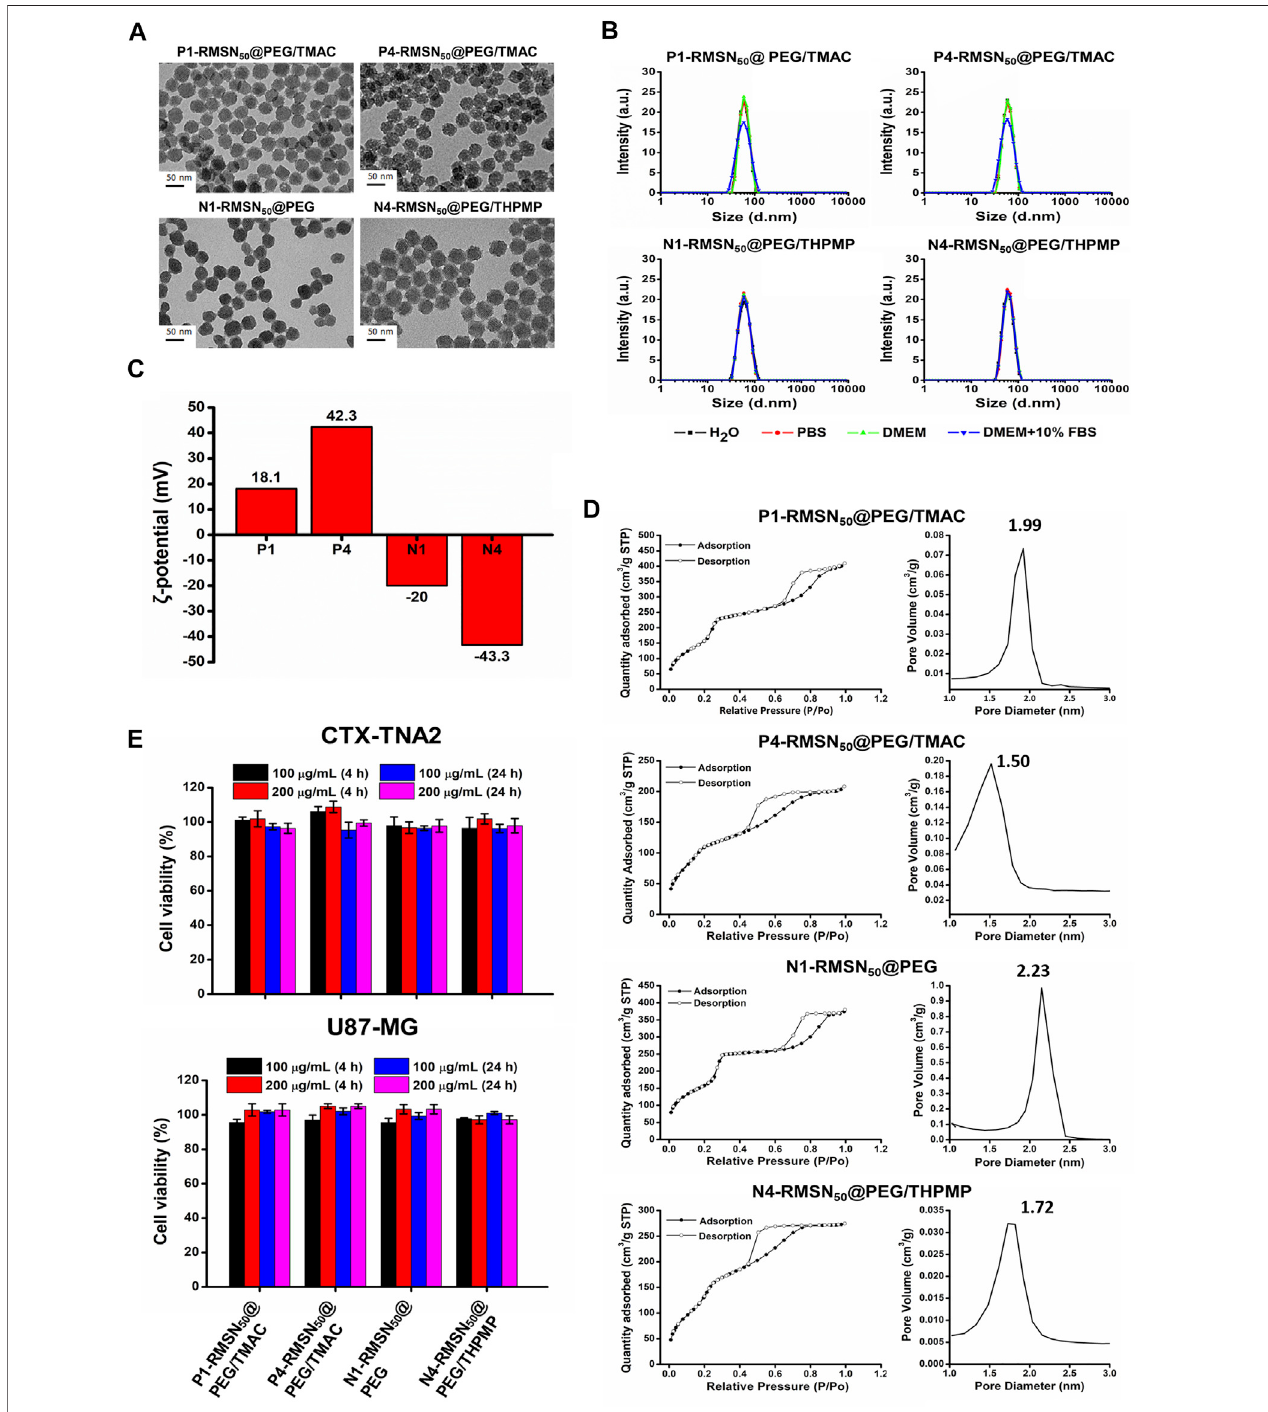
FIGURE 1 | Physical characterizations and cytotoxicity of four types of RITC-conjugated mesoporous silica nanoparticles (RMSNs). (A) TEM images. Scale bar = 50 nm. (B) DLS, (C) zeta potential, and (D) nitrogen adsorption/desorption isotherms and corresponding pore size distribution plot of various types of RMSNs. (E) Cytotoxicity assay. CTX-TNA2 and U87-MG cells were cultured with different concentrations (100 and 200 μ g/ml) of various types of RMSNs for 4 and 24 h in 10% serum-containing medium. Cell viability was detected using an MTT assay.